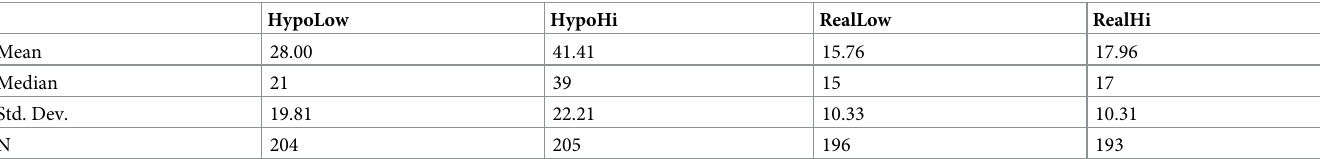
Table 12. Experiment 3: WTPs by treatment (in